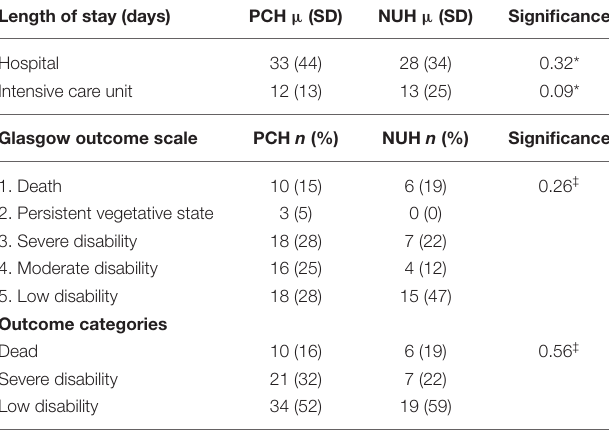
TABLE 6 | Functional and institutional outcomes. Length of stay (days)